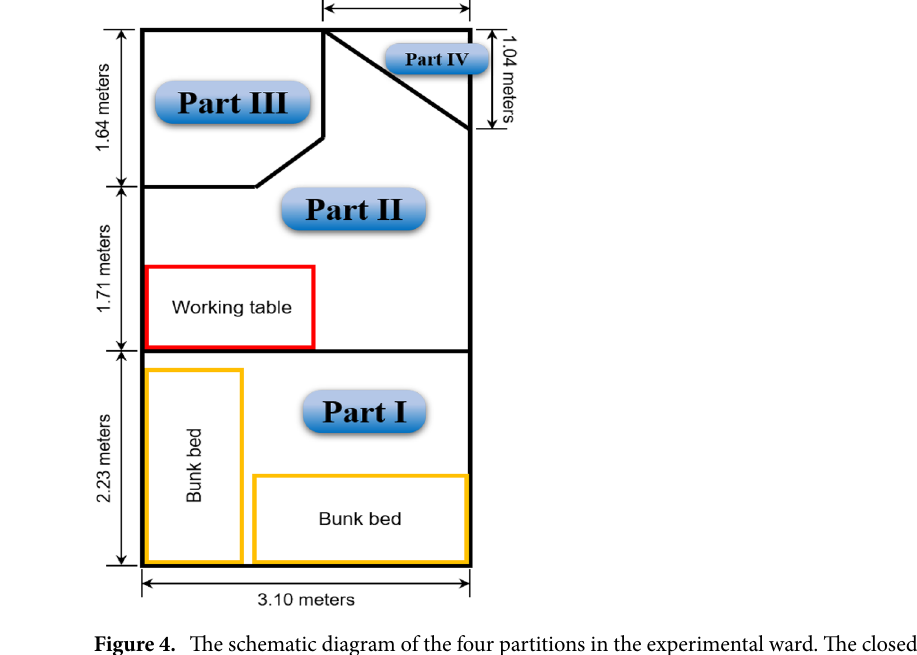
Figure 4. The schematic diagram of the four partitions in the experimental ward. The closed experimental environment contains Parts I, II, and III. (The figure was generated by PowerPoint 2019, URL: https:// www. micro softs tore. com. cn/ softw are/